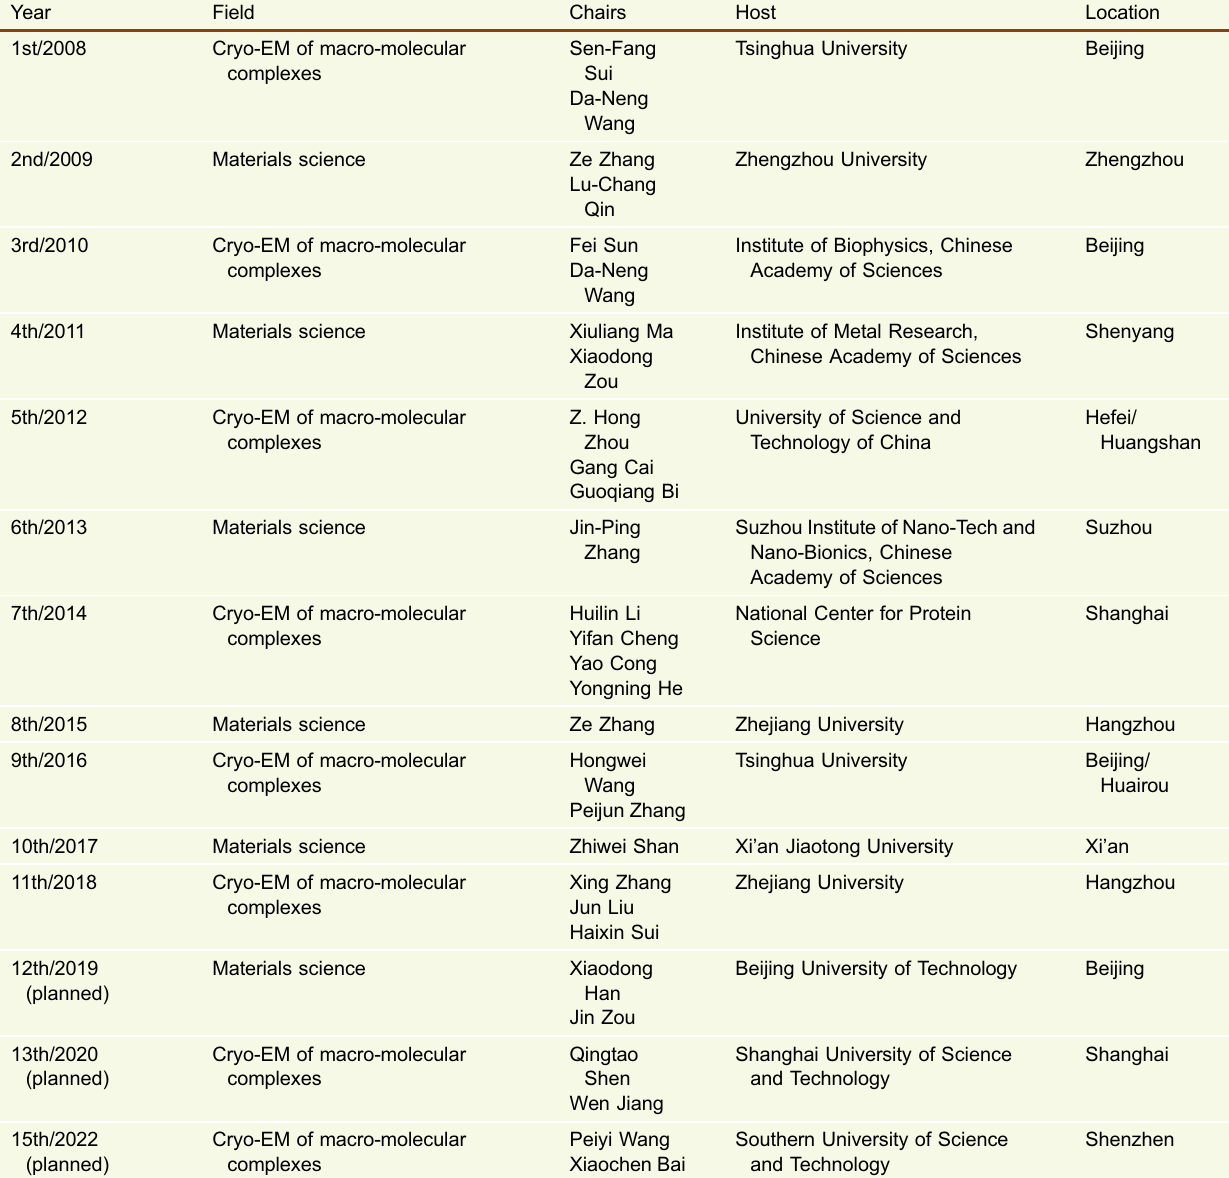
Table 1. K. H. Kuo Summer School of Electron Microscopy and